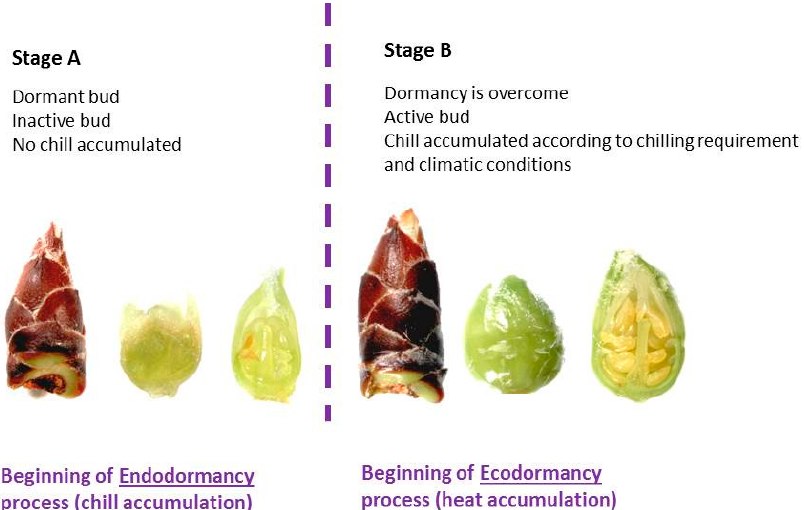
Figure 1. Plant material assayed from the almond cultivar ‘Desmayo Largueta’. Flower buds in the dormant stage ( A ) and after dormancy release ( B ).